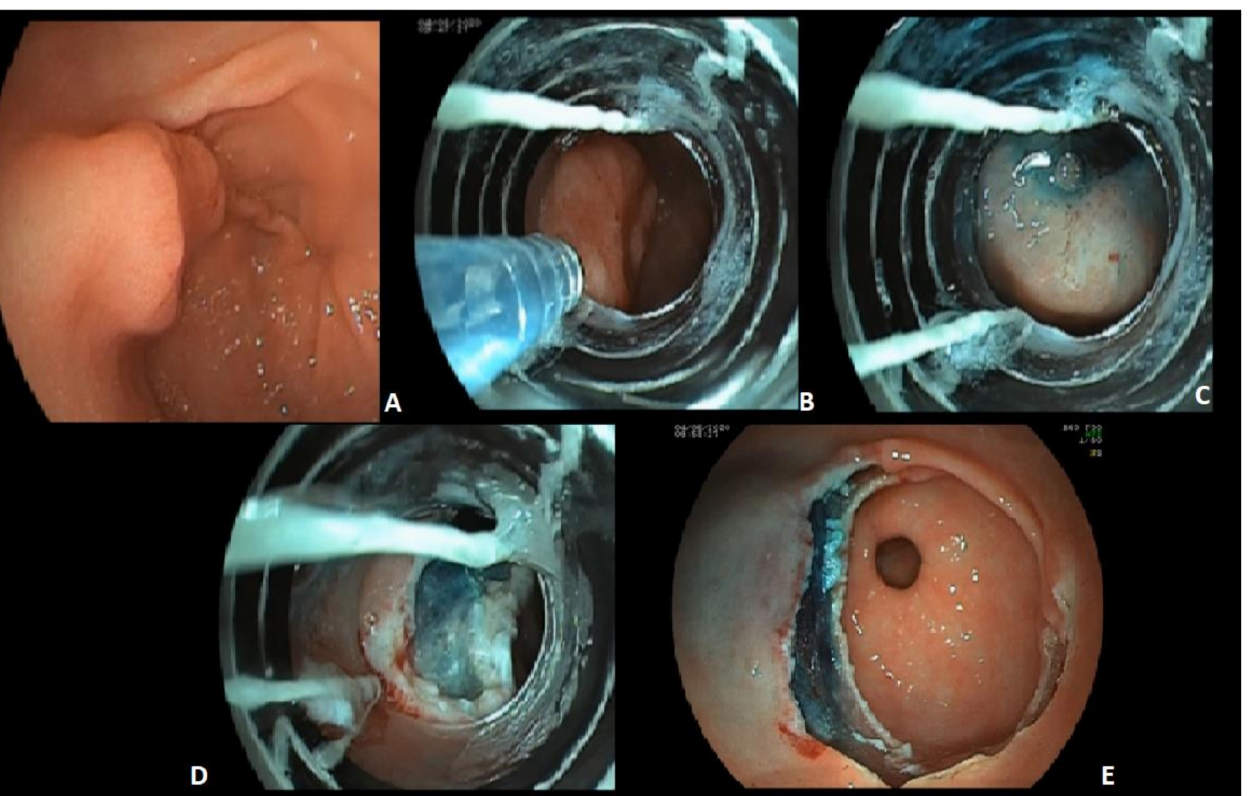
Figure 3. Cap-assisted EMR of a T1a early gastric cancer 1 cm in size, located in the antrum. The figures show: the entire lesion ( A ); the endoscopic device for cap-assisted EMR and the needle filled with the lifting solution approaching the lesion ( B ); the lesion after lifting, before the suction in the cap and the resection ( C ); the antrum immediately after the resection ( D ); the surface of the antrum after the resection and the exposed submucosal layer ( E